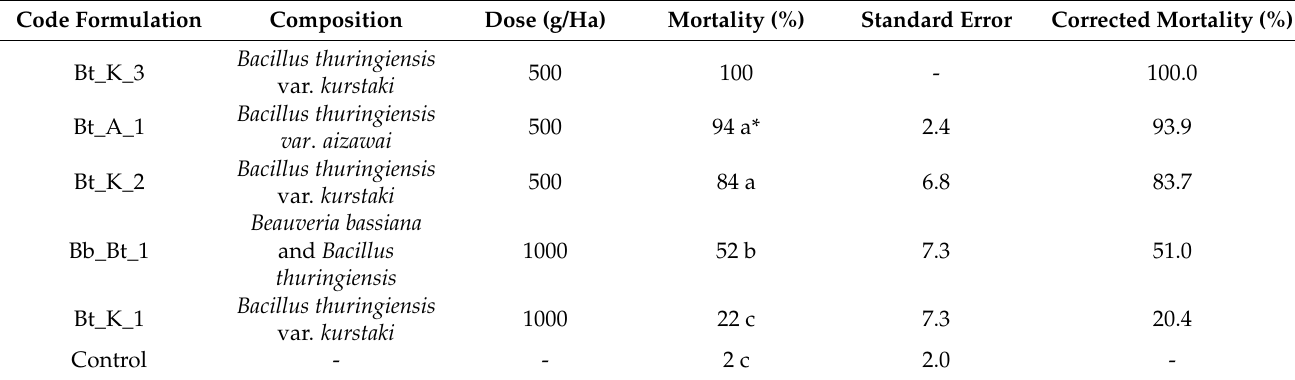
Table 2. Mean mortality of Stenoma impressella larvae achieved with five commercial formulations of Bacillus thuringiensis evaluated under laboratory conditions (i.e., 26.8 ± 0.4 ◦ C and 73.7 ± 9.2% relative humidity), over nine